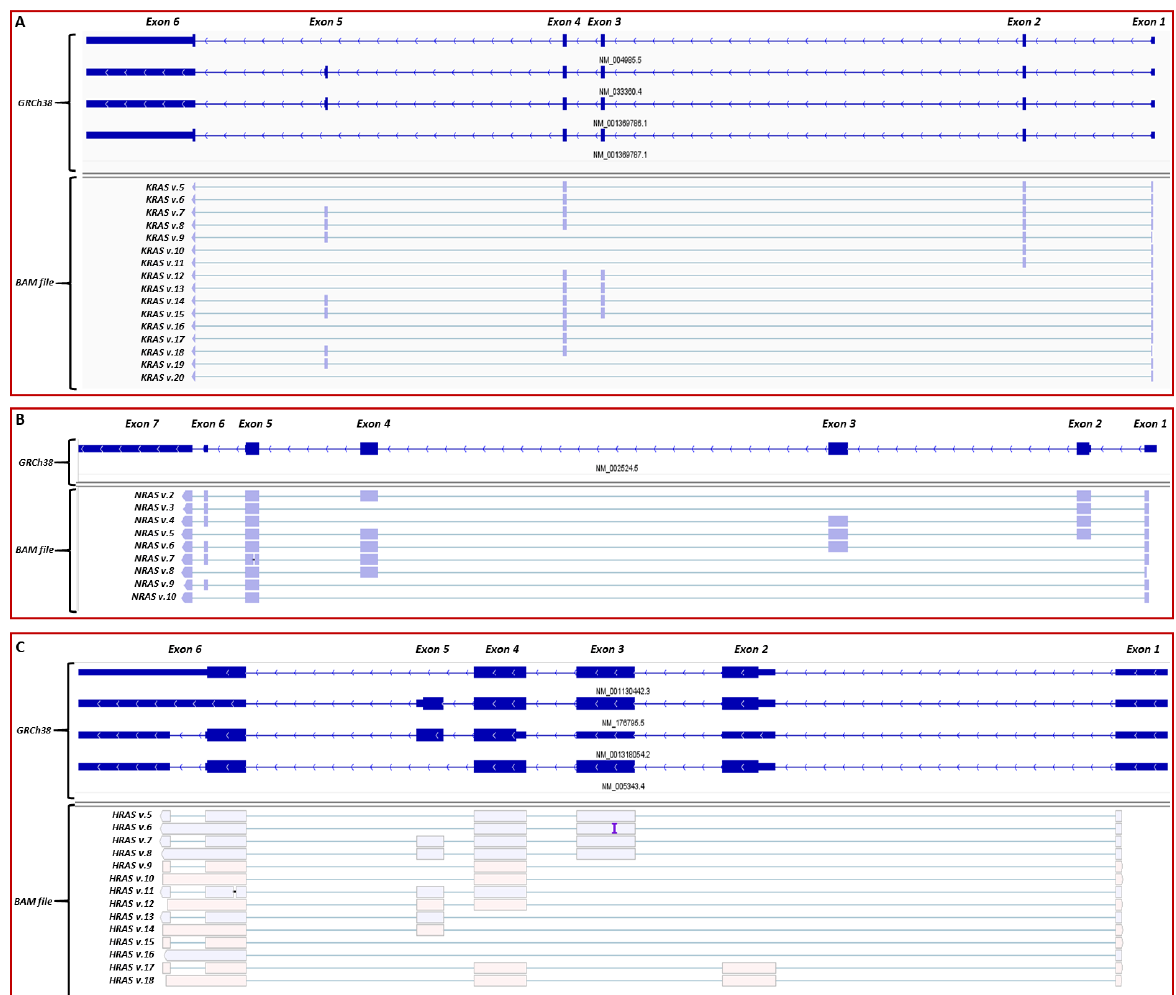
Figure 1. Visualization of aligned sequencing reads representing the novel RAS mRNA transcripts described in the present study, using IGV. The human genome 38 (GRCh38) was used as reference. ( A ) Visualization of the 16 novel KRAS transcripts ( KRAS v.5 – v.20). ( B ) Visualization of the 9 novel NRAS transcripts ( NRAS v.2 – v.10). ( C ) Visualization of the 14 novel HRAS transcripts ( HRAS v.5 – v.18).